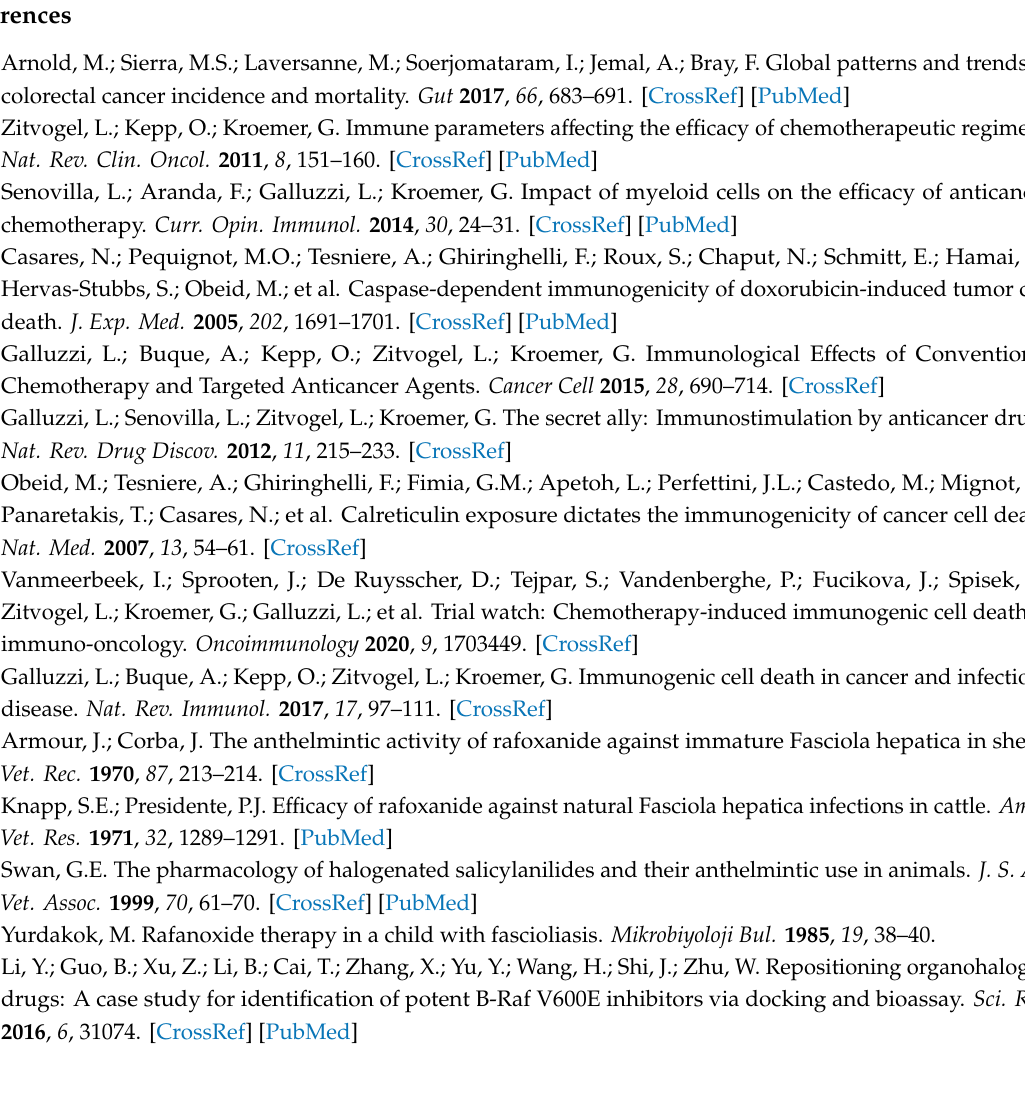
Figure S1: Uncropped blots for p-eIF2 α (Ser51), eIF2 α , and β -actin representing those depicted in Figure 1A, Figure S2: Six h rafoxanide treatment does not a ff ect HCT-116 and DLD1 cell survival, Figure S3: Uncropped blots for LC3 and β -actin representing those depicted in Figure 2A, Figure S4: Uncropped blots for p-eIF2 α (Ser51), eIF2 α , and β -actin representing those depicted in Figure